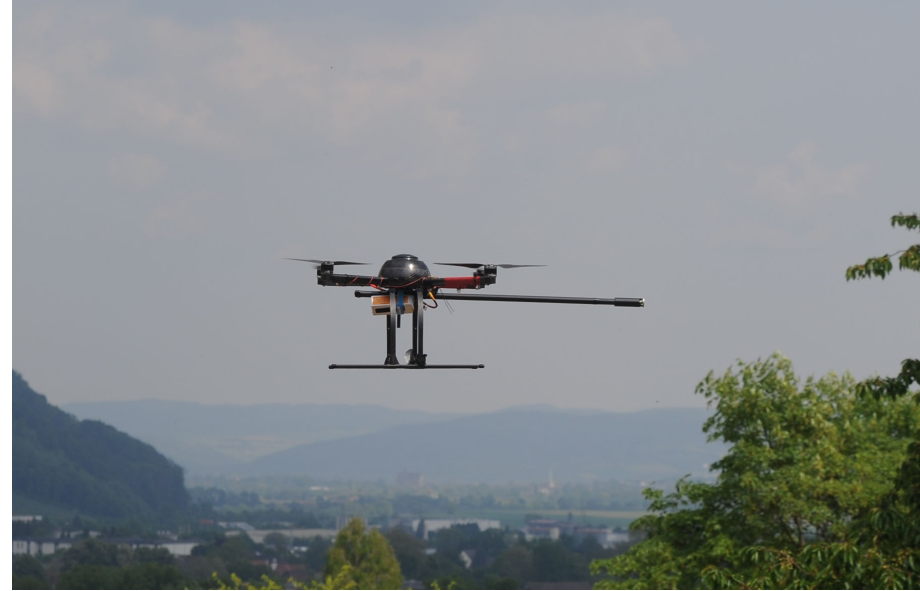
Figure 3. Q13 Remotely Piloted Aircraft System (RPAS) with a sensor mast horizontally attached. The length of the mast is suitable to prevent a significant impact by the multicopter’s